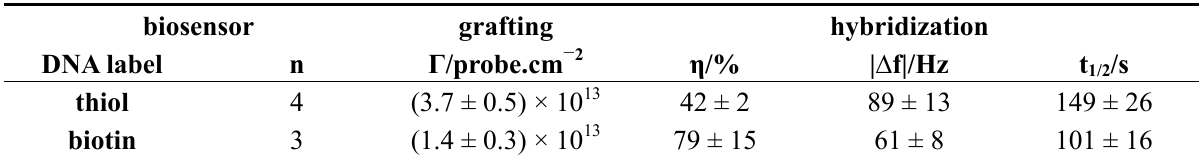
Table 2. Biosensor grafting and hybridization characteristics and behaviors: oligonucleotide label (5'); number n of biosensors designed; probe density  (probe  cm − 2 ) on the gold covered quartz surface; hybridization efficiency  %); quartz frequency change  f (Hz) during DNA target hybridization and half-time t (s) of biosensor hybridization reaction.  DNA